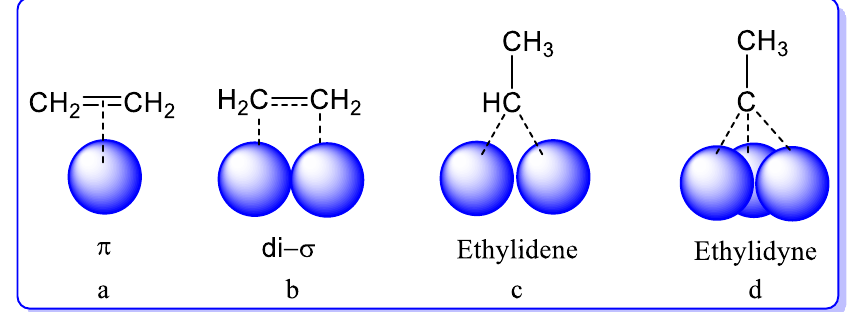
Figure 10. The interaction of ethylene with metal surface atoms.